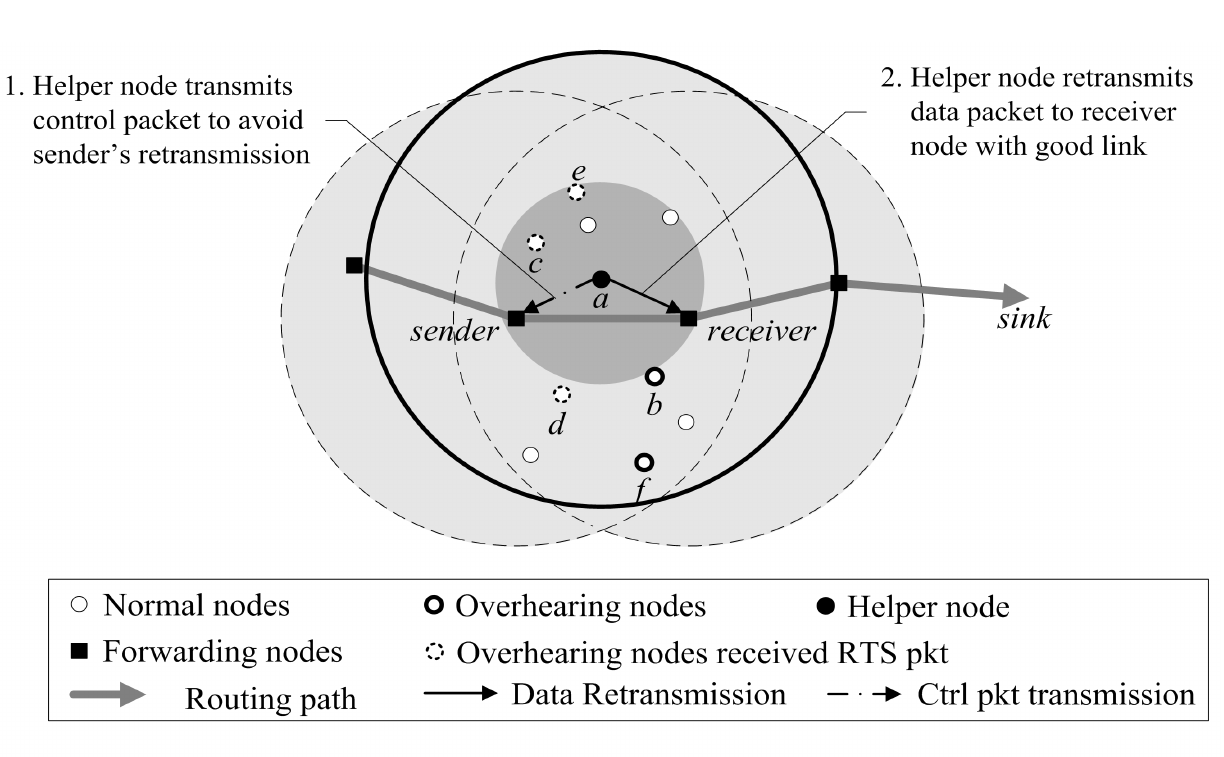
Figure 5. Transmission phase by helper